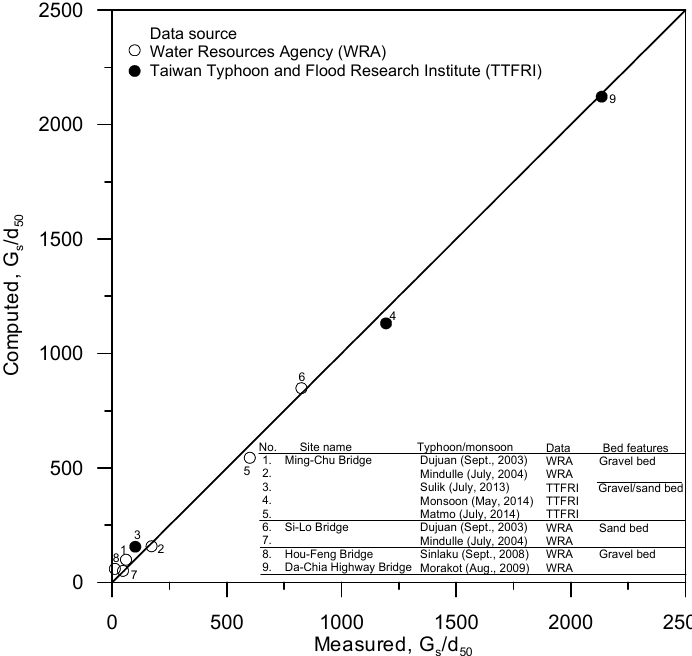
Figure 8. Comparison of general scour depth between measured data and computed results.